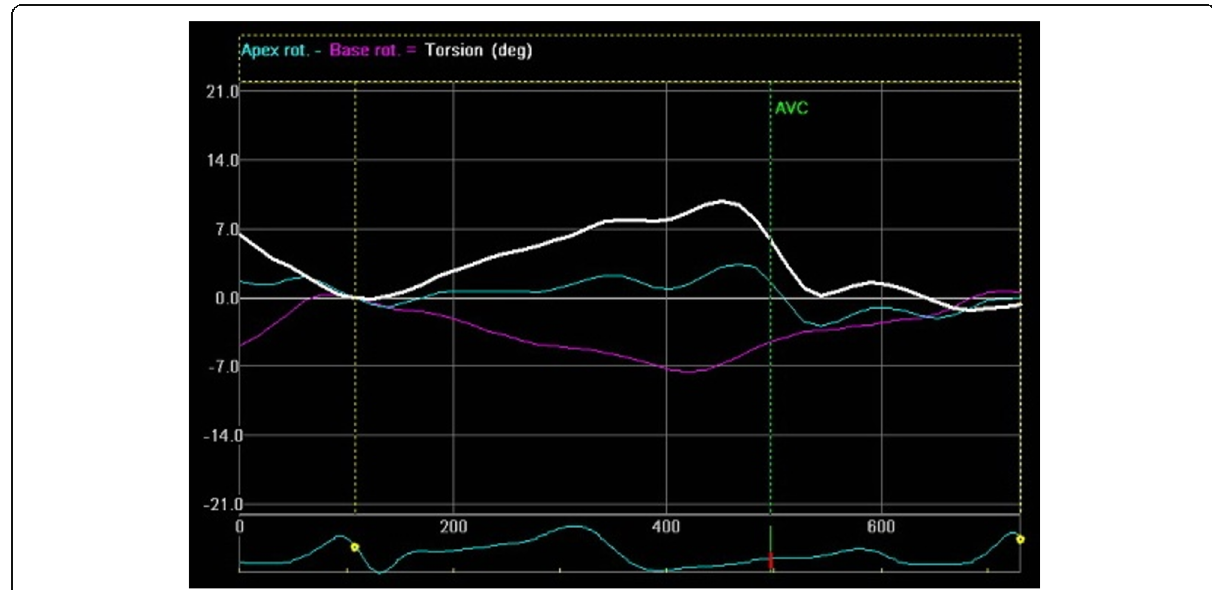
Fig. 3 Speckle tracking echocardiography (Echo Pac software) in normal subjects showing net basal rotation (purple color) in counter-clockwise direction and net apical rotation (green color) in clockwise direction. Net torsion is displayed in white color